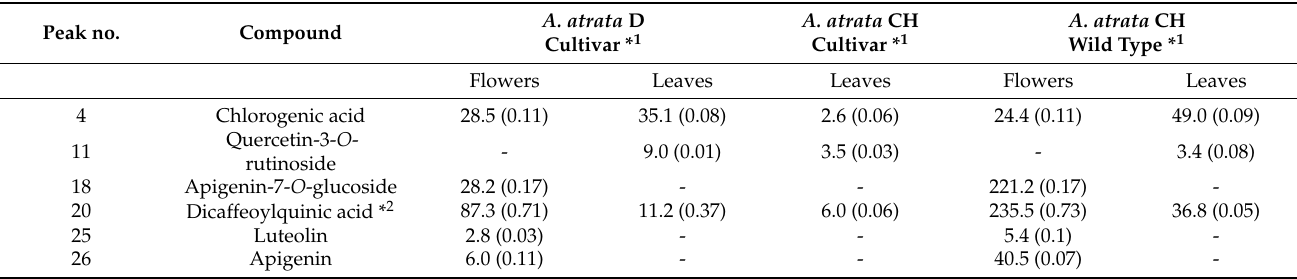
Table 2. Quantitation of selected phenolic compounds in two cultivated A. atrata variants (Germany/D, Switzerland/CH) and in the wild type